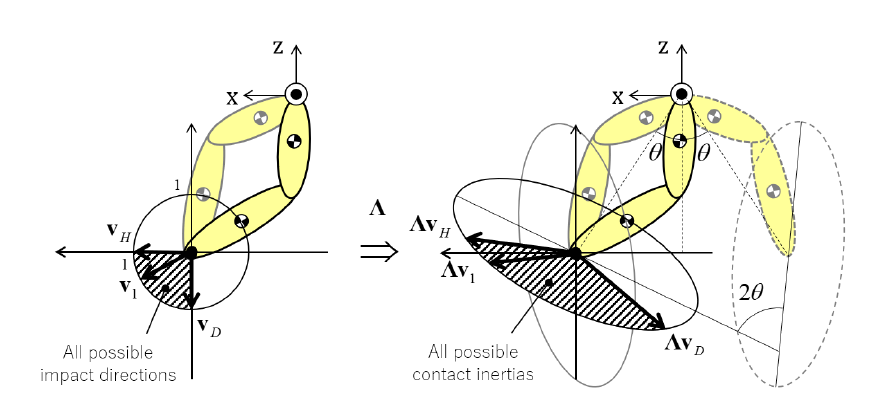
Figure 11. CI for all possible impact directions and CIEs depending on flexion direction.